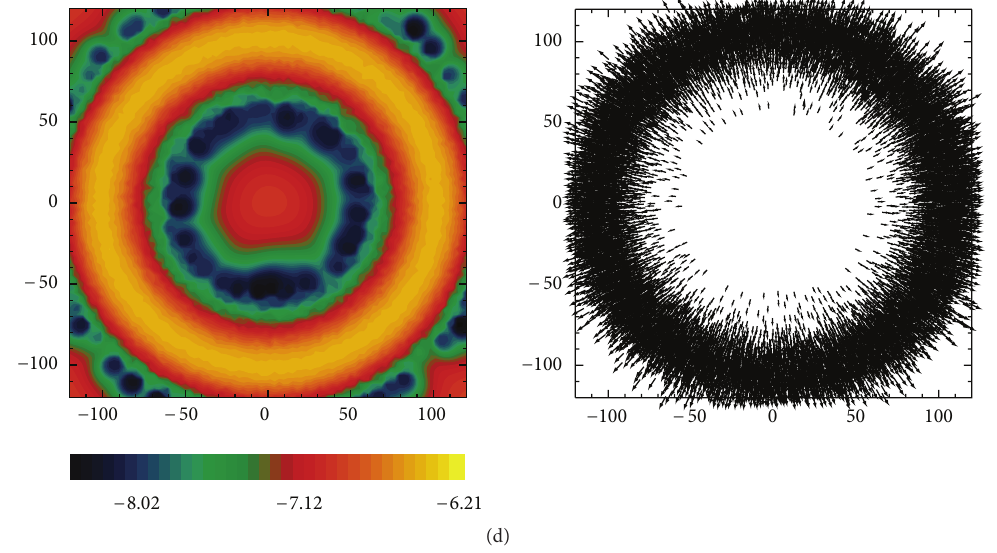
Figure 4: Iso-density and velocity plots for the T models, from (a) to (d), T1 (a), T2 (b), T3 (c), and T4 (d), respectively.